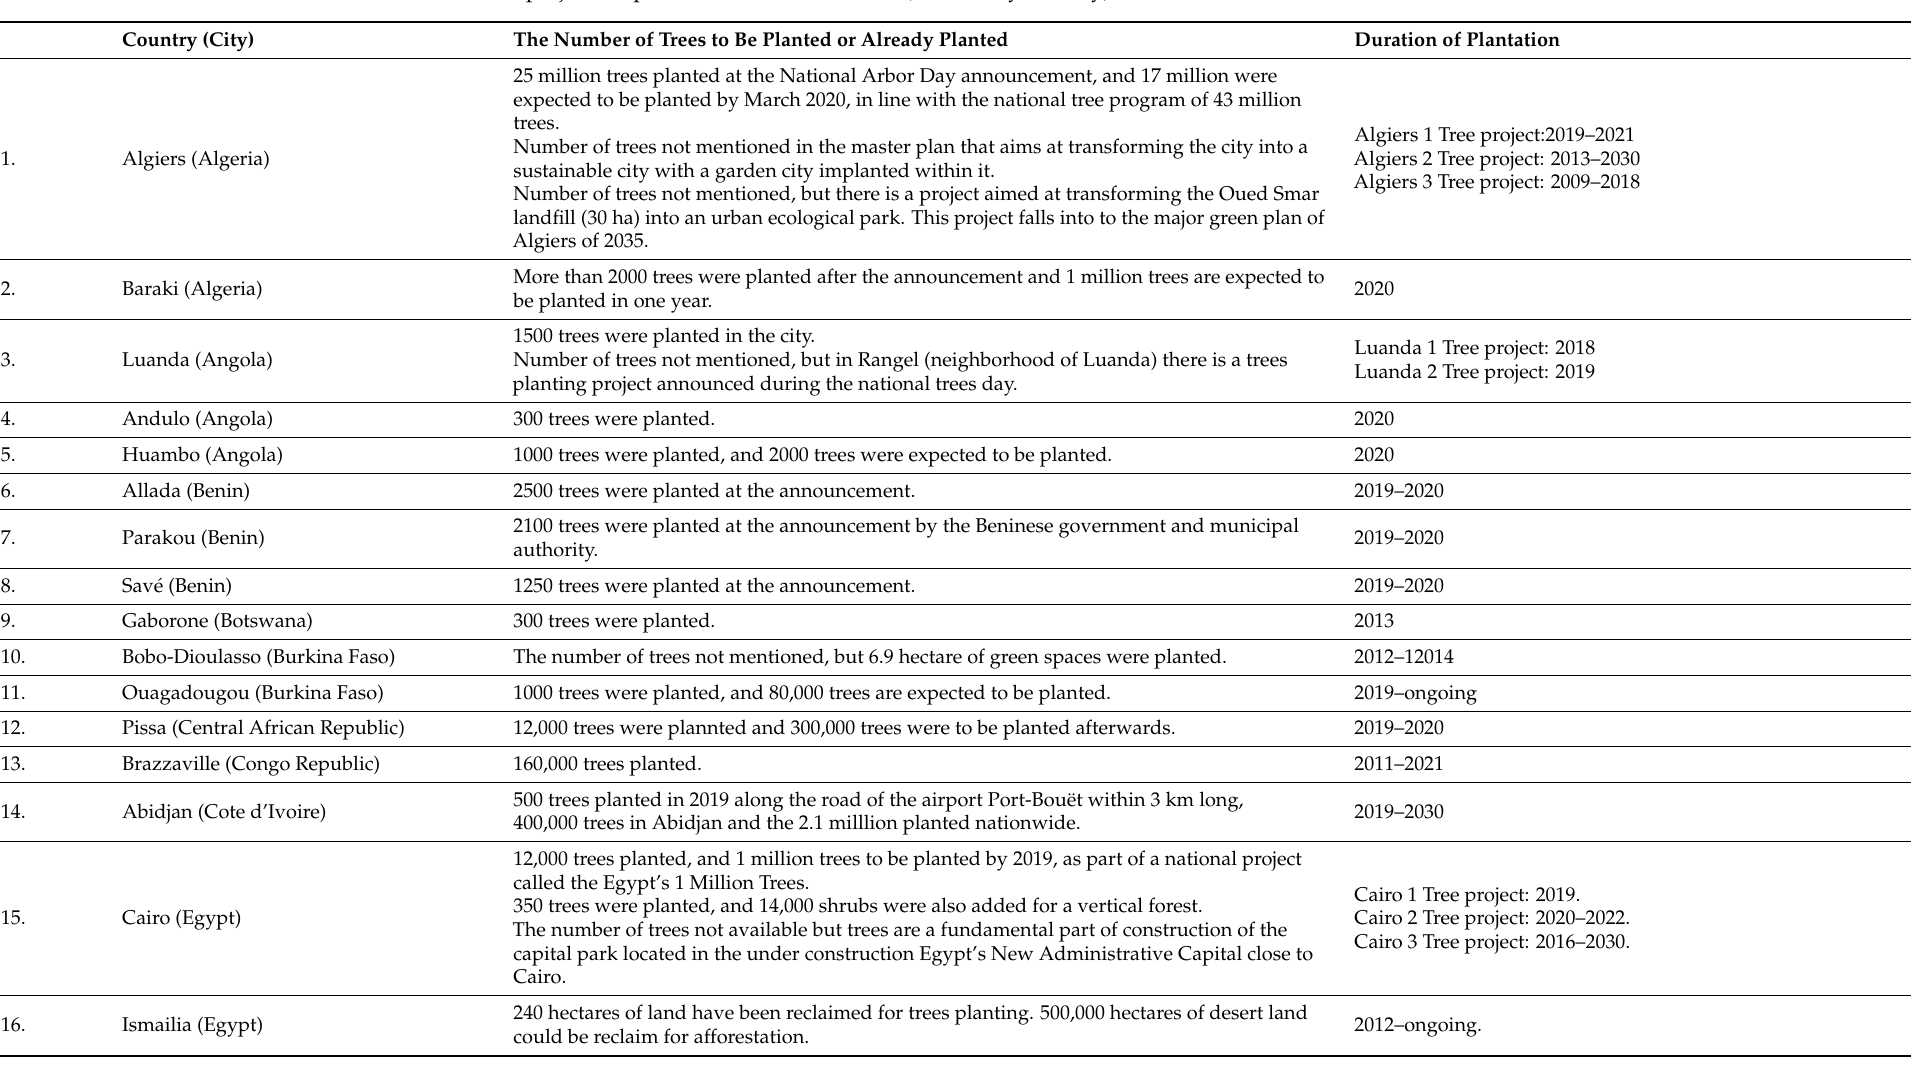
Table 1. Overview of projects to plant trees in African cities (ordered by